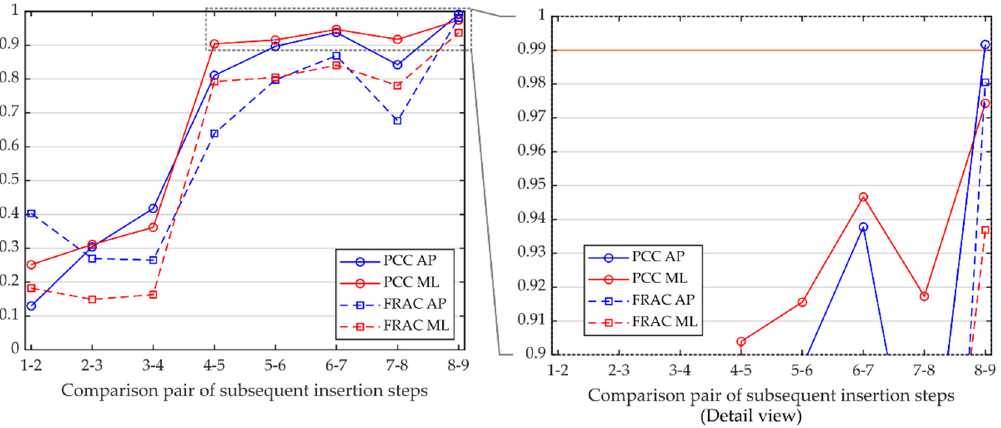
Figure A1. PCC and FRAC development for insertion without soft tissue. The PCC threshold (indicated in orange) is reached at the step 8–9 transition.